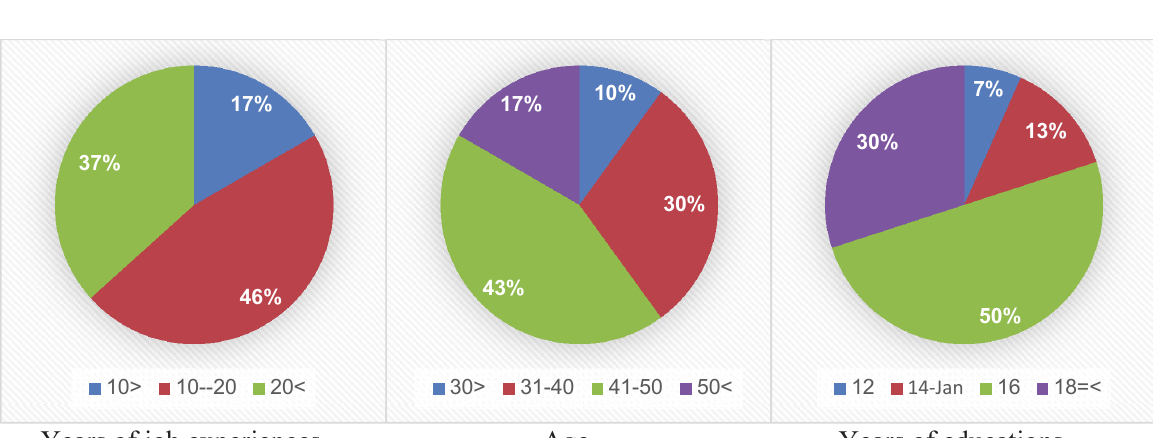
Fig. 3. Personal characteristics of the participants